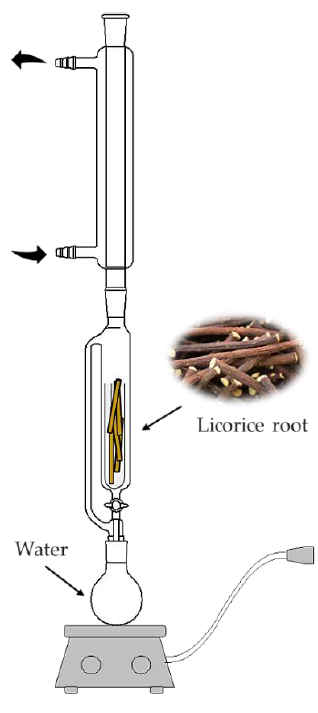
Figure 13. Licorice root extraction scheme.